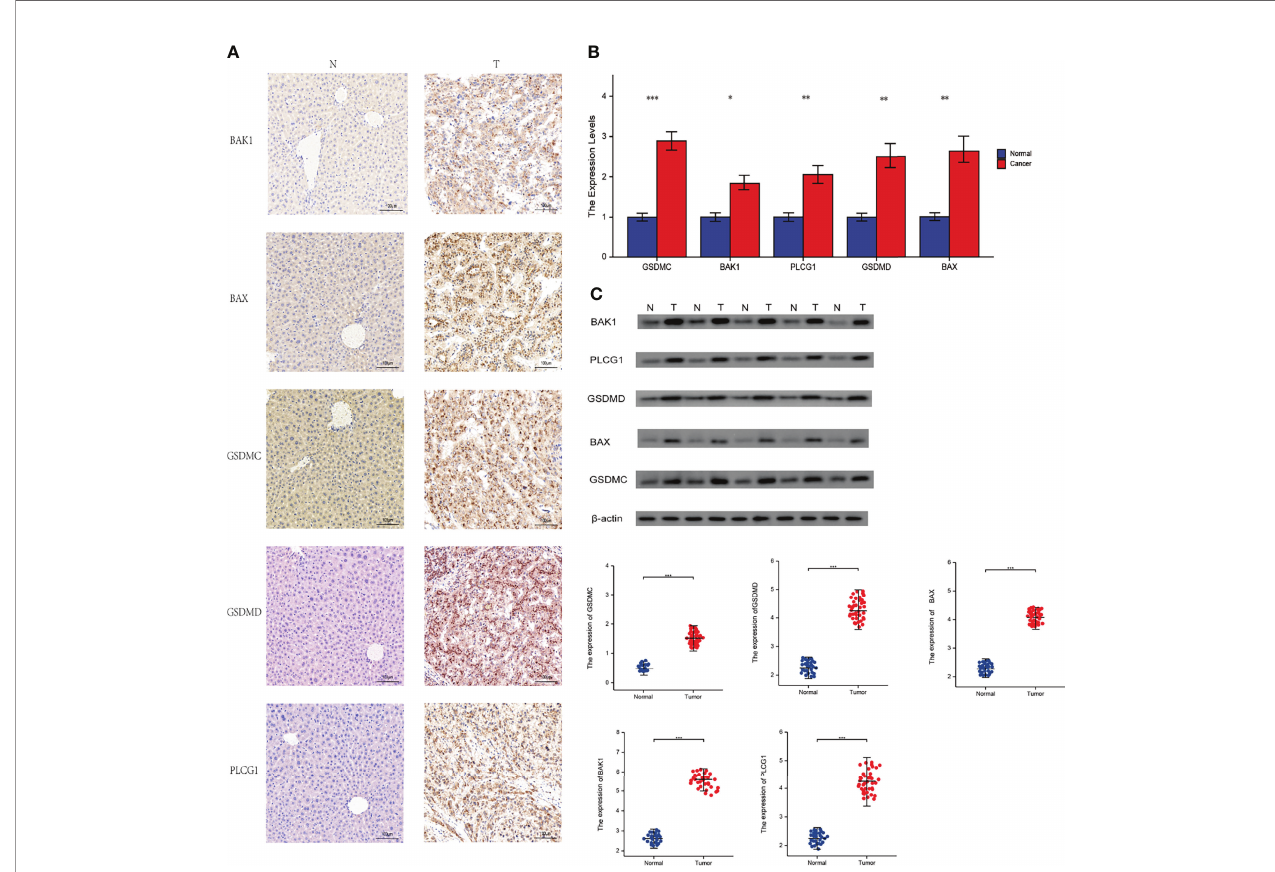
FIGURE 10 | Experimental veri fi cation. T, tumor; N, normal. (A) Immunohistochemical stainings of 5 necroptosis genes in HCC. (B) Results of PCR analysis. (C) Results of Western Blot. * P < 0.05; ** P < 0.01; *** P <